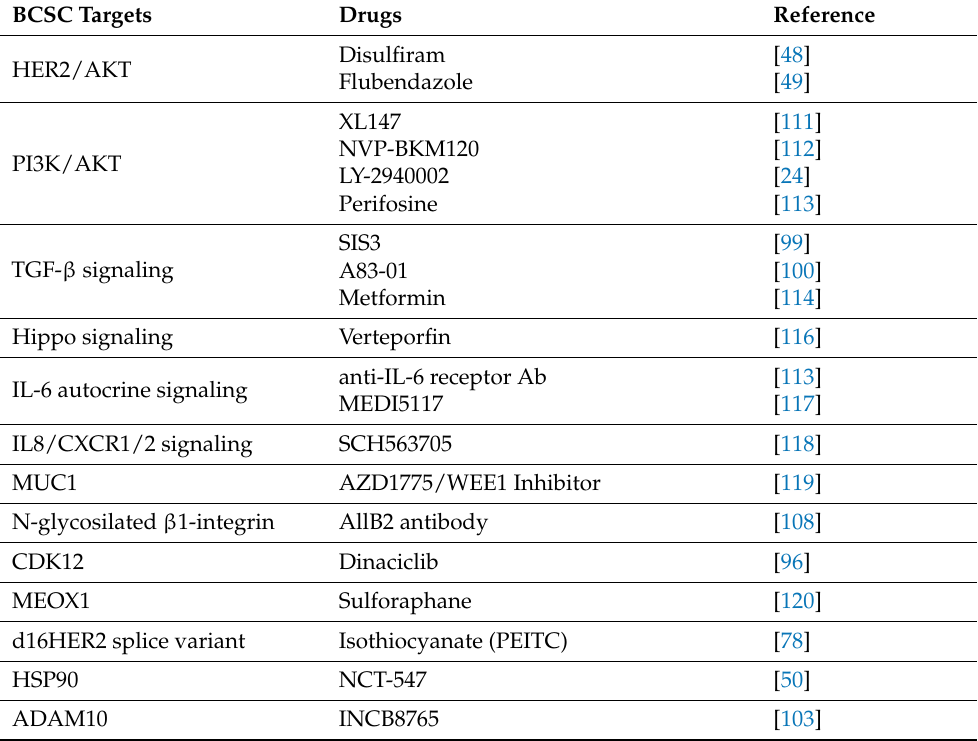
Table 1. Targeting of BCSCs in HER2+ BC models refractory to trastuzumab